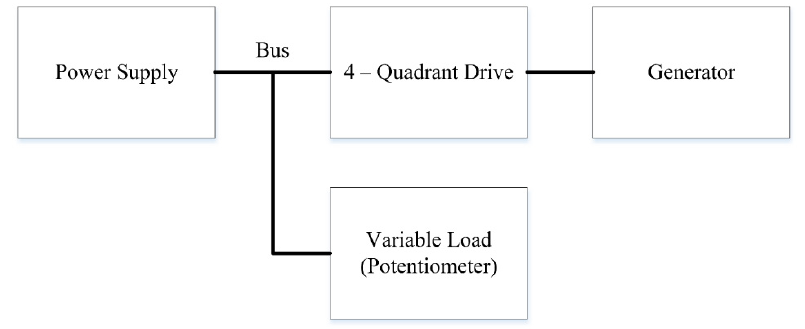
Figure 8. Power Take Off circuit.